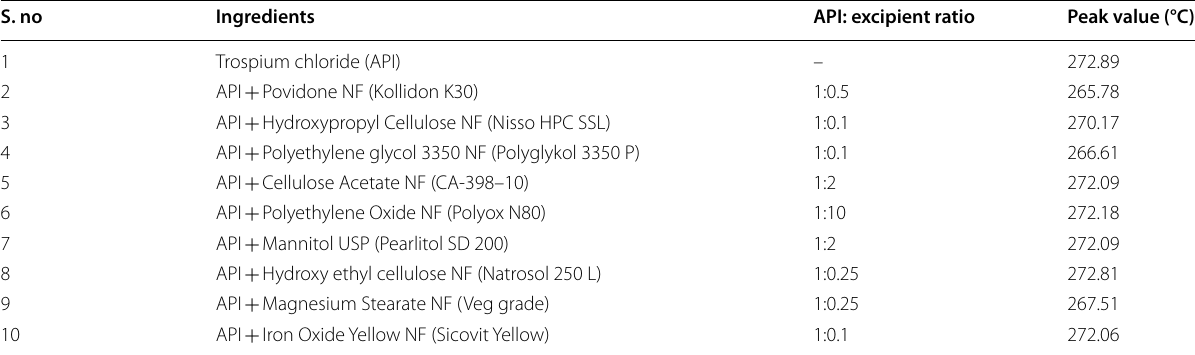
Table 6 DSC data of the peak values of the pure drug and the mixture of drug and excipients S.